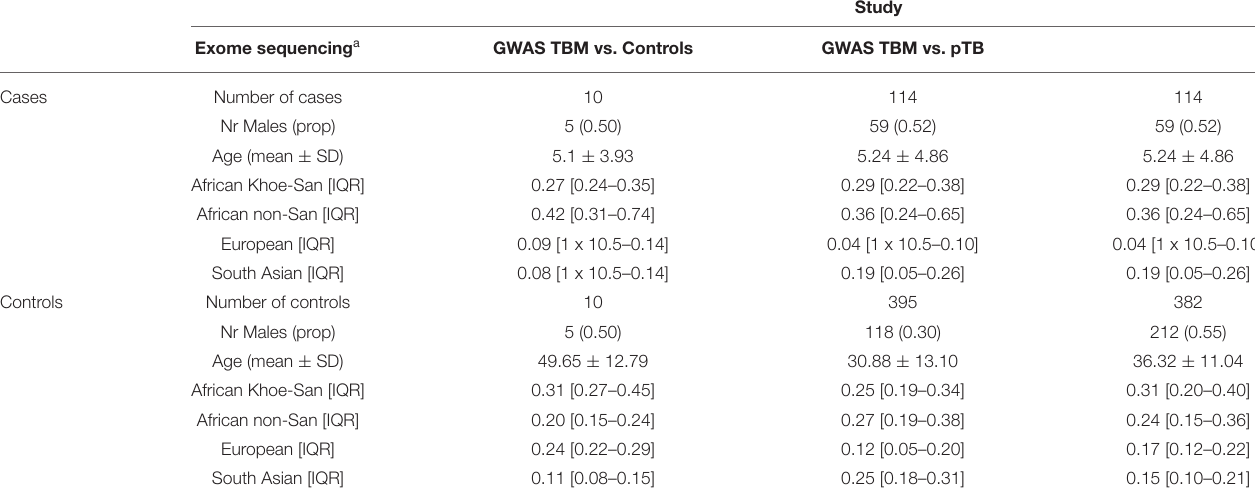
TABLE 1 | Sample characteristics including sex, age, and ancestry proportions per study